Question: Which kind of chart has been used to present this data?
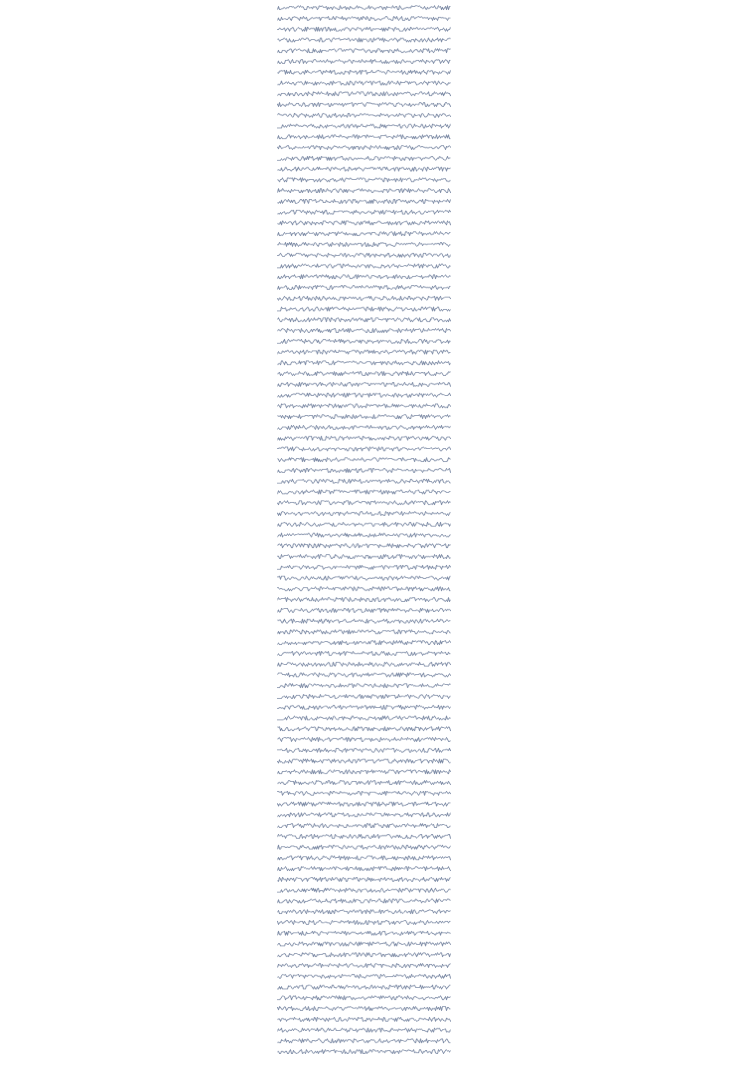
Answer: line